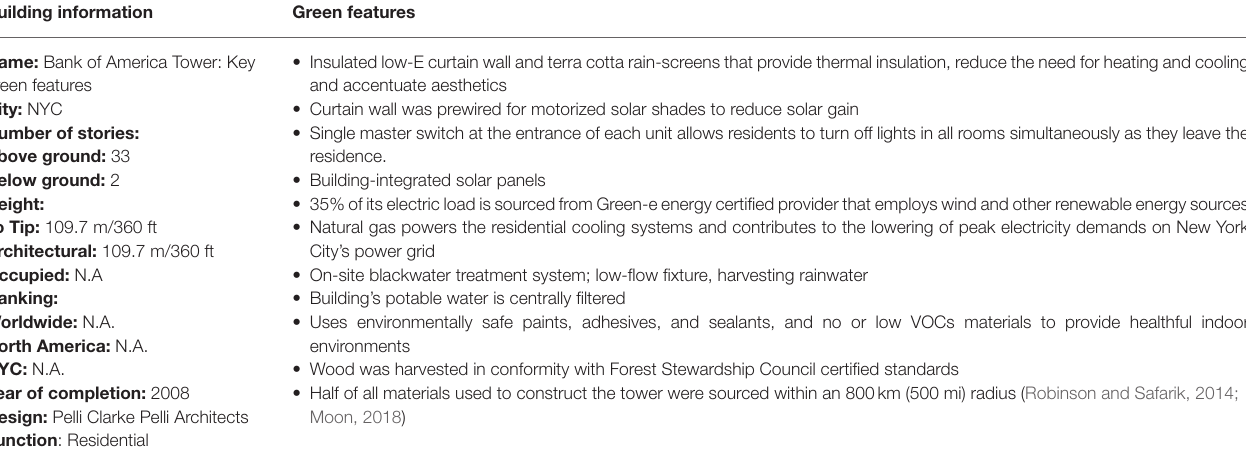
TABLE 2 | Key green